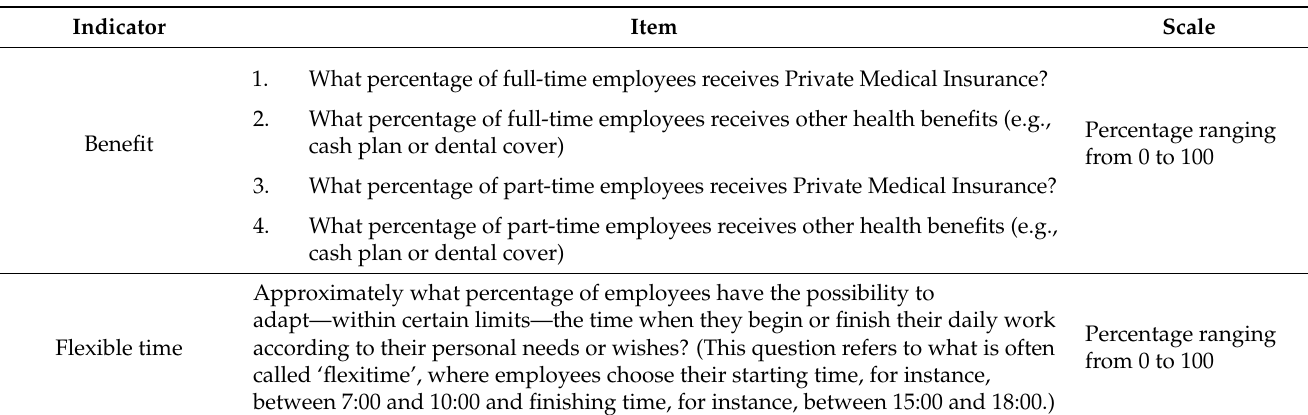
Table A1. List of the items used for measuring the organizational practice